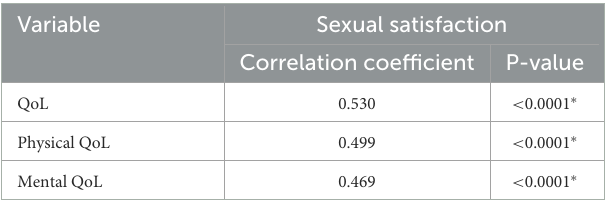
TABLE 4 Correlation between sexual satisfaction and quality of life